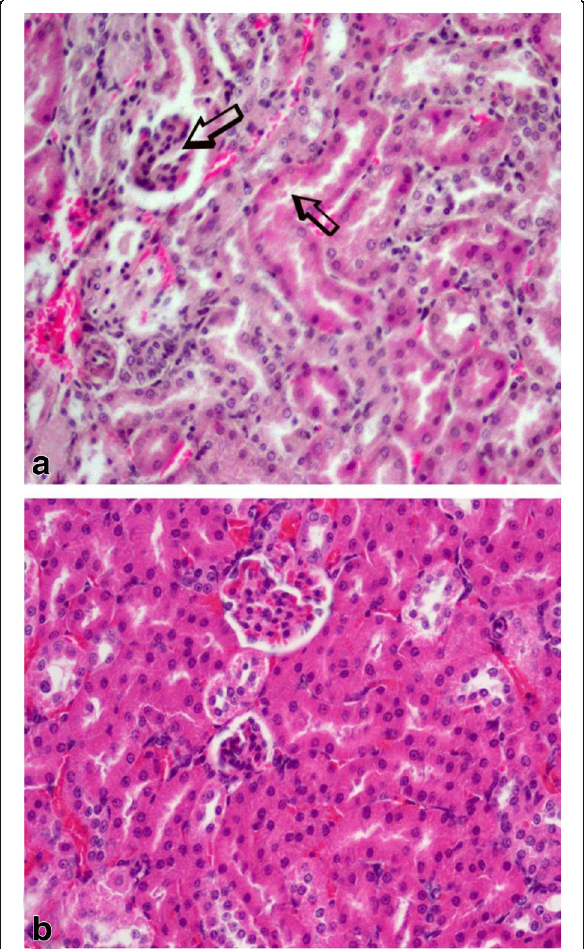
Fig. 10 Histological section of the kidney from mice that received 2000 mg/kg, 8 hourly intervals but died on 2nd day of treatment. There is a mild hydropic degeneration of cortical-tubular epithelium and glomerulus in ( a ). Section ( b ) is from normal kidney for comparison. Magnifications, ( a & b ) 400 x